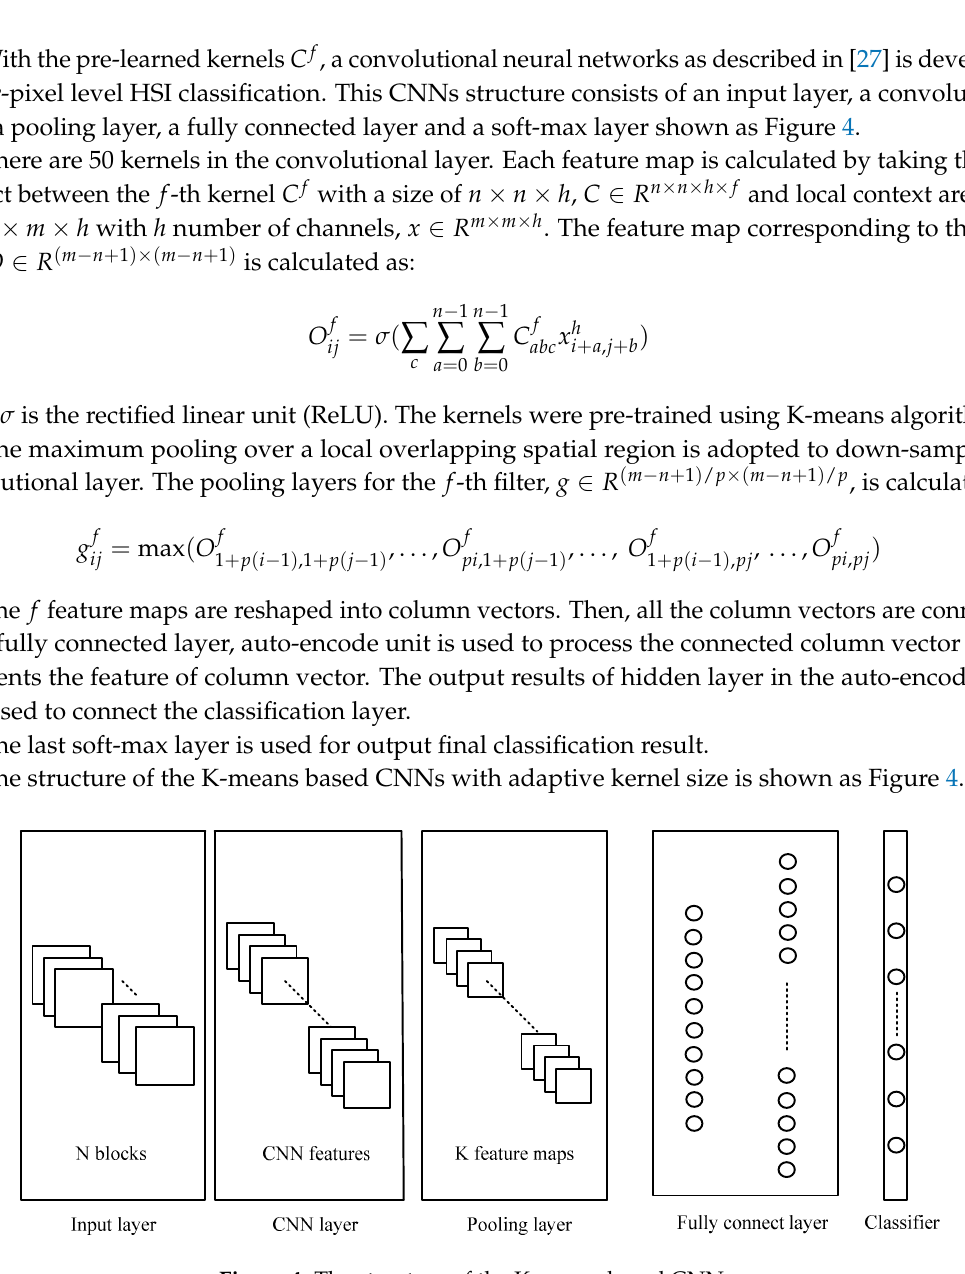
Figure 4. The structure of the K-means based CNNs.